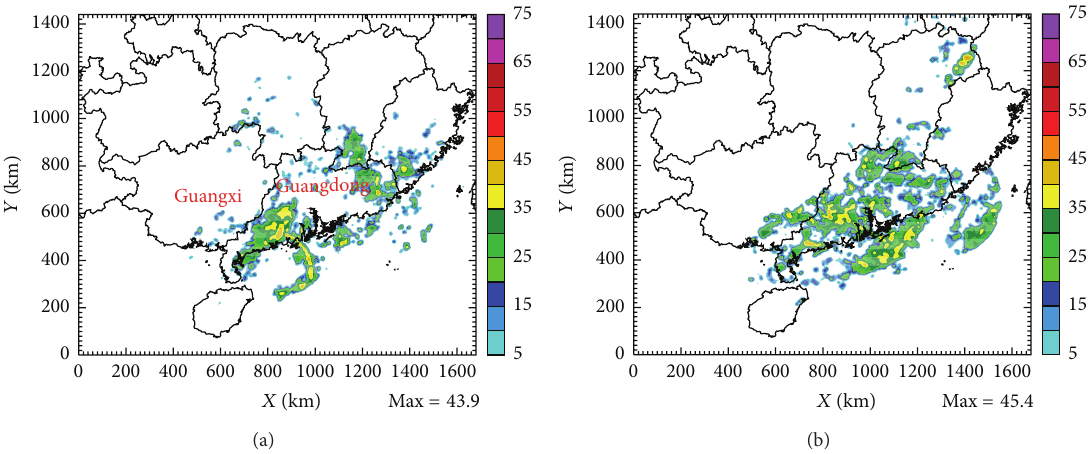
Figure 3: Composite reflectivity from observations at (a) 1200 UTC June 29, 2011 and (b) 1200 UTC July 15, 2011.